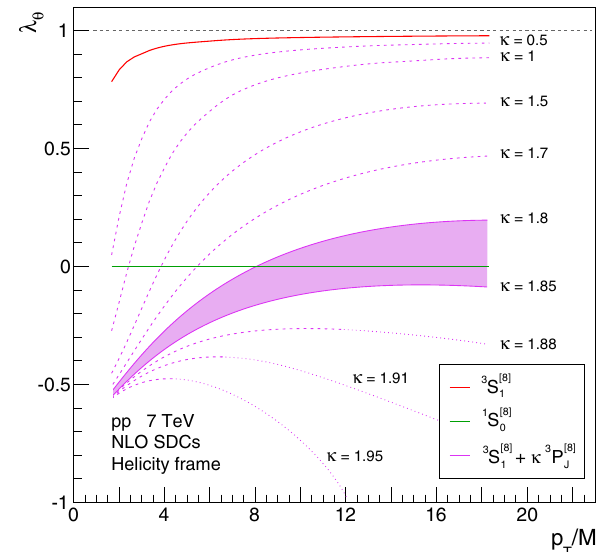
Fig. 1 The dominating colour-octet SDCs for the direct production of 3 S 1 quarkonia in NLO NRQCD, as functions of p T 3 S [ 8 ] (red), and several 3 S [ 8 ] 1 band represents the κ = 1 . 8–1.85 range, which matches very well the shape of the (arbitrarily normalized) 1 S [ 8 ] 3 P [ 8 ] octets, all of the same order, v 4 (the 3 S J